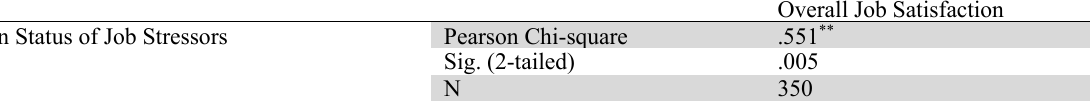
Chi-square tests for Status of Job